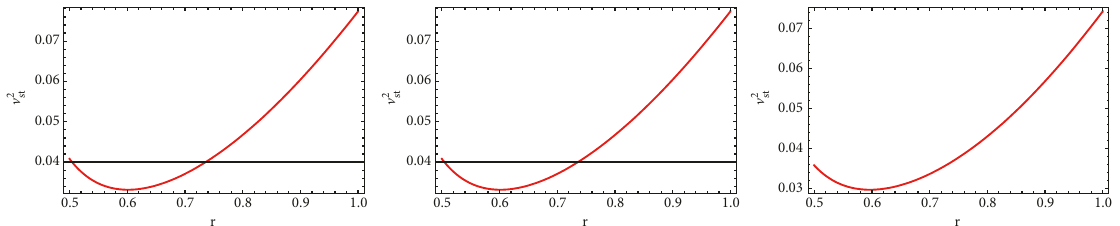
Figure 16: This figure represents the variation of V 2 𝑠𝑡 versus 𝑟 (km) for the strange star taking 𝛽 = 1 , 𝛽 = 2 , and 𝛽 = 3 .